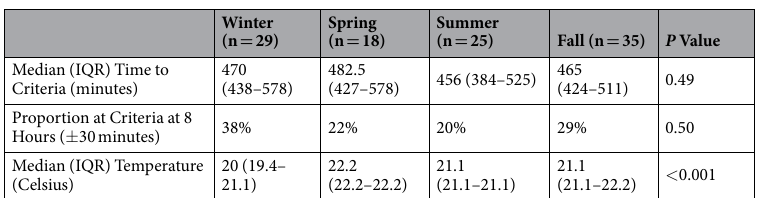
Table 2. Seasonal variation in the response to cecal ligation and puncture. Sub-cohorts of mice are delineated by season of experimentation. The median time to meeting criteria for acute physiologic deterioration, proportion of mice meeting criteria within the 8 hour time point after cecal ligation and puncture, and median experimental room ambient temperature are calculated for each seasonal cohort of experimental